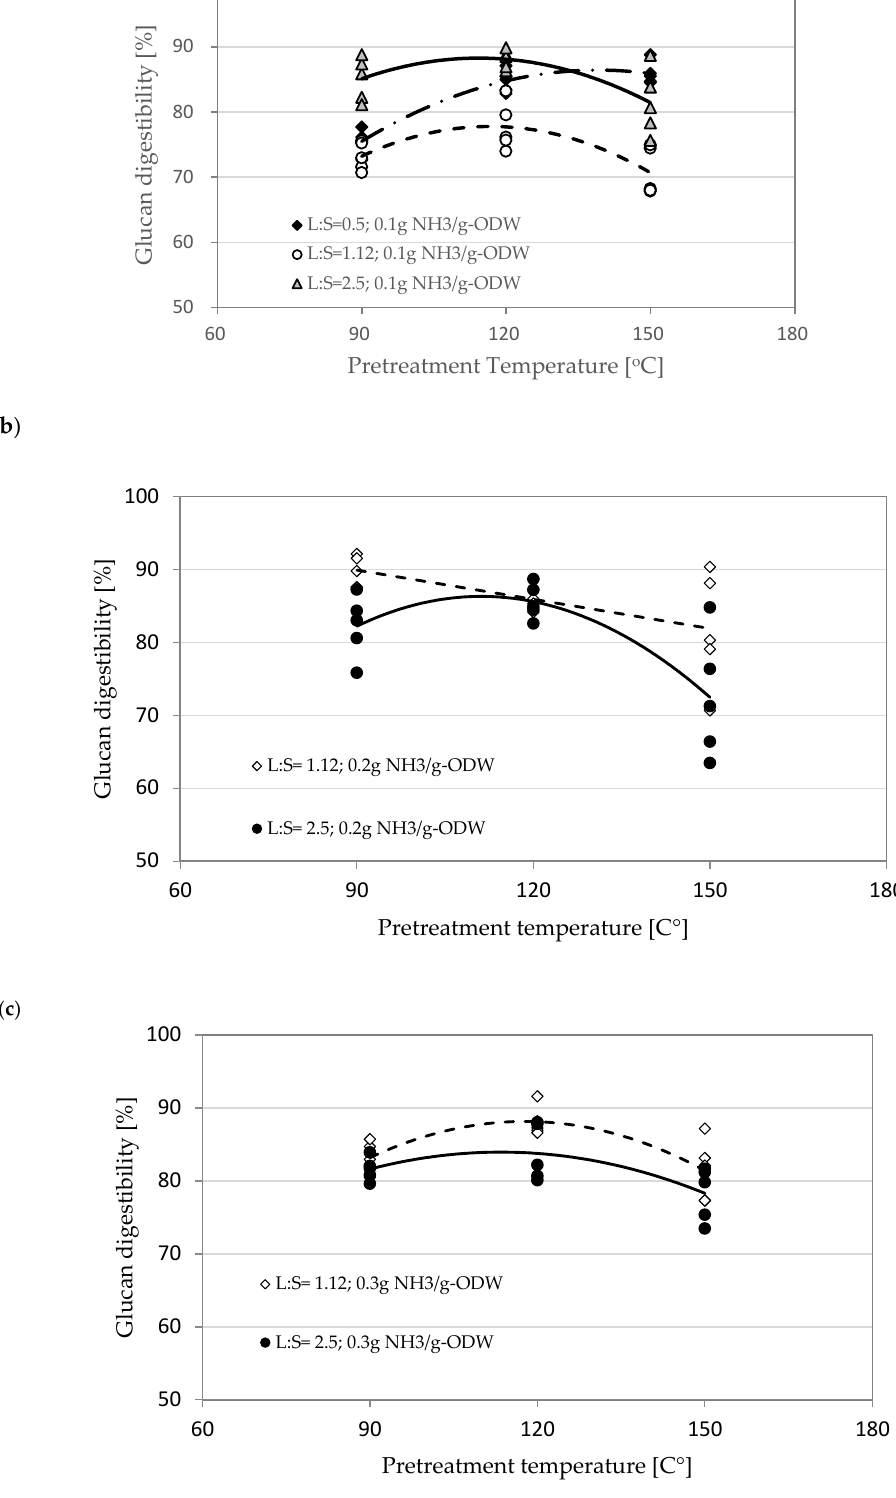
Figure 5. Effect of L/S ratio on enzymatic digestibility of corn stover. ( a ) 0.1 g NH 3 loading, ( b ) 0.2 g NH 3 loading, ( c ) 0.3 g NH 3 loading ELLA treatment conditions: L/S = 0.55, 1.12, 2.5; 0.1–0.3 g- NH 3 /g-biomass, 90–150 ◦ C, 24–120 h. Enzymatic hydrolysis conditions: CTech2; 15 FPU/g-glucan loading; 50 ◦ C; 150 rpm; hydrolysis time, 72